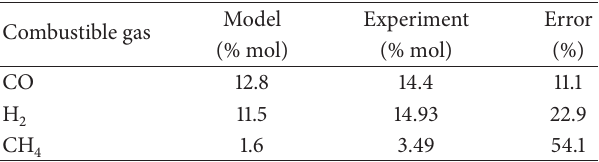
Table 5: Comparison between models and experiments for gas composition in ER 0.3 and fraction of pyrolysis gas recirculation of